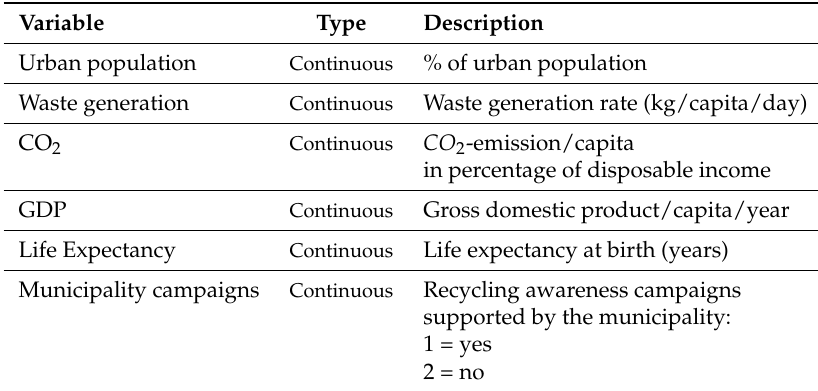
Table 1. Description of all of the analyzed